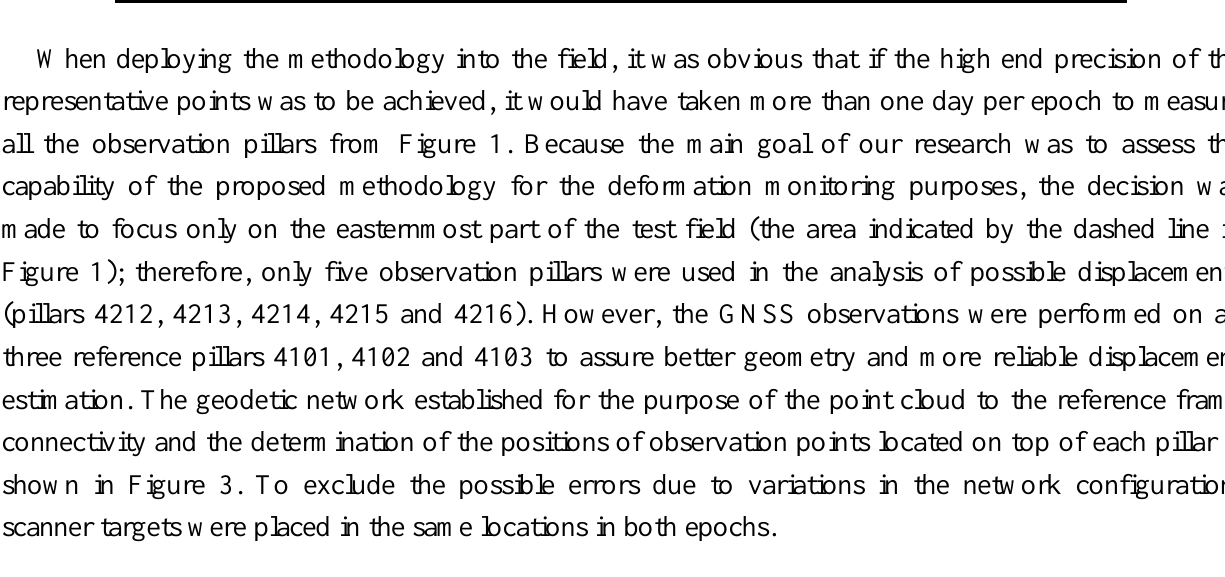
Figure 3. The geodetic network designed near the object of the